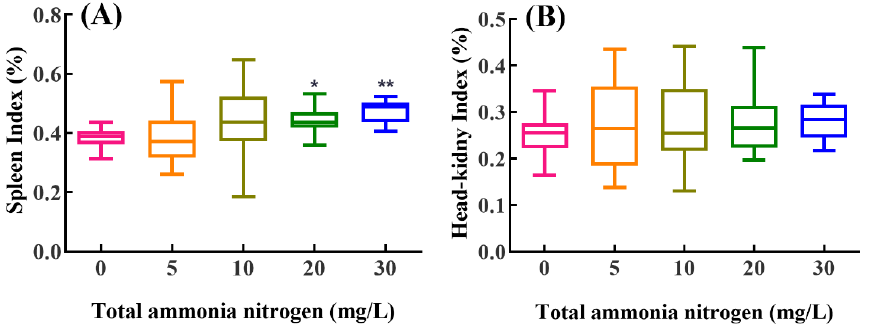
Figure 3. Effects of chronic ammonia exposure on spleen ( A ) and head-kidney indexes ( B ) in M. amblycephala . Values are expressed as Min to Max ( n = 18). The values of p < 0.05 and 0.01 are represented as “*” and “**” above the column, indicating significant difference versus control, respectively.